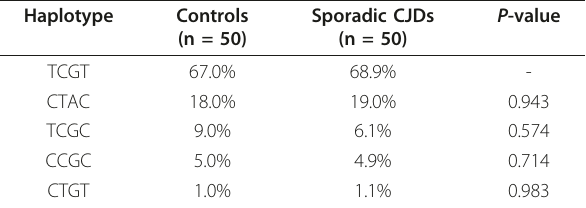
Table 5 Haplotype frequency of RPSA polymorphisms in controls and sporadic CJD